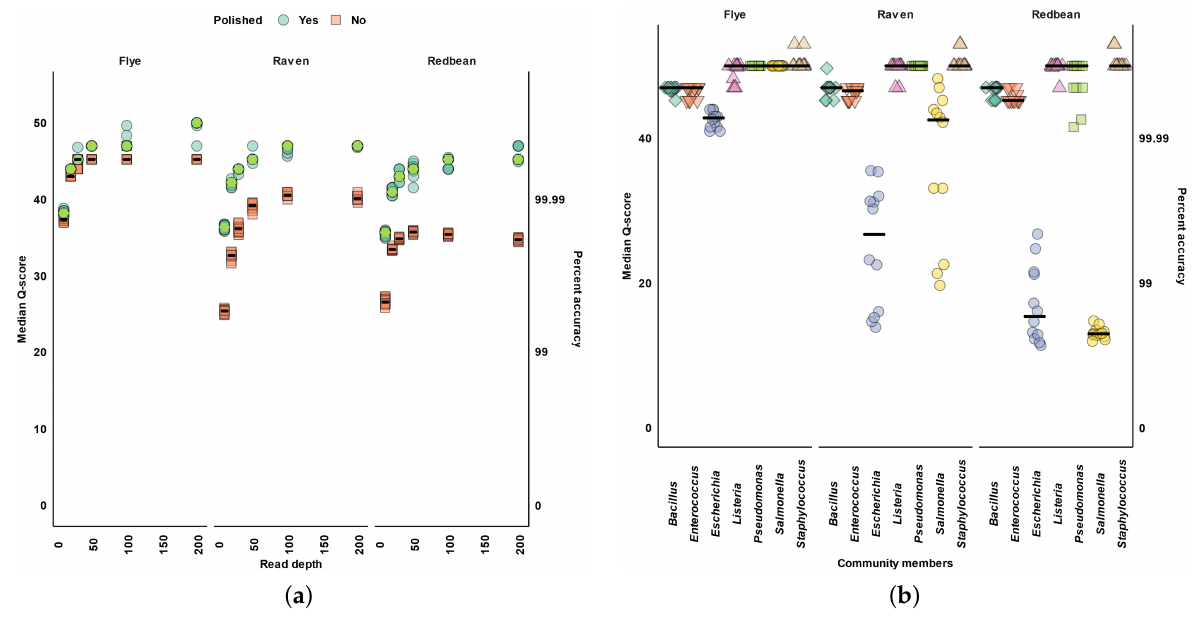
Figure 2. Chromosome accuracy. ( a ) Median quality (Q-score) for chromosomes before (red/orange squares) and after polishing (blue/green circles). ( b ) Individual community member median Q-score at 200 × read depth. Horizontal bars indicate the median across subsamples. Color and shape indicate different community members ( b ).